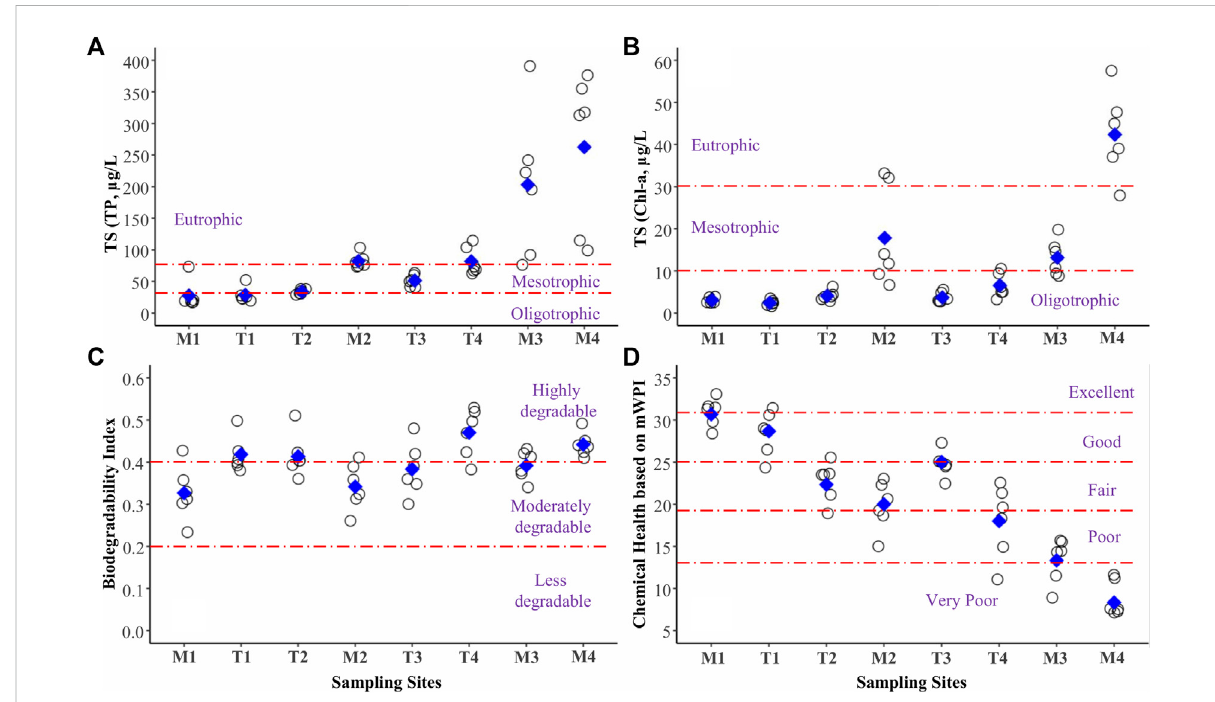
FIGURE 3 Spatial variations of river trophic state based on TP (A) and Chl-a (B) , biodegradability (C) , and chemical health using mWPI (D)